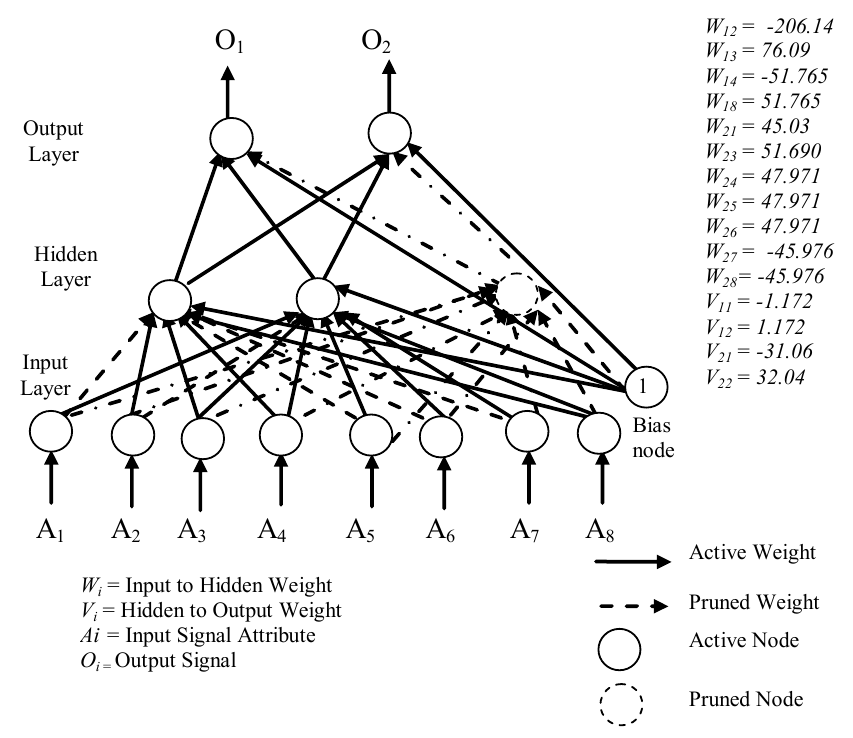
Figure 6. A pruned network for the diabetes